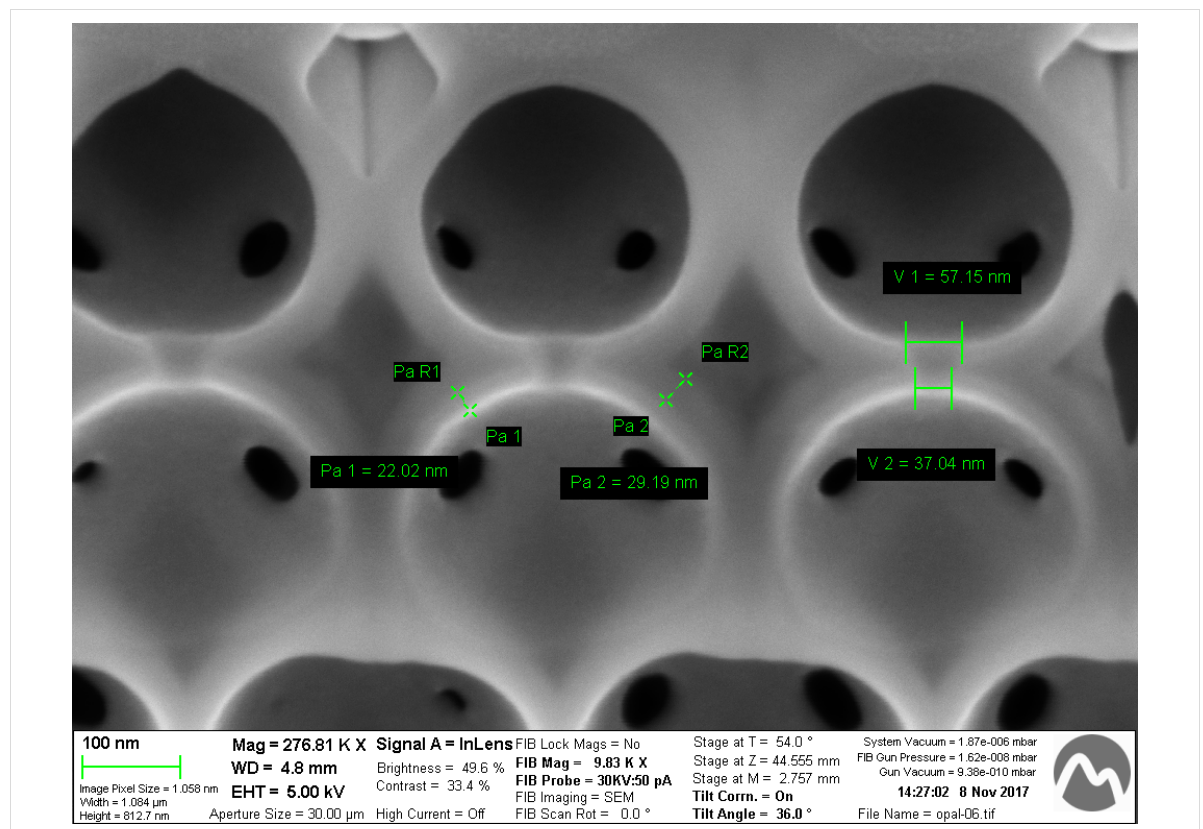
Figure 4: Cross section of Al 2 O 3 /TiO 2 shells after TiO 2 layer deposition. Conformal shells are observed covering the Al 2 O 3 layer. Pa1 stands for the thickness of TiO 2 and Pa2 stands for the thickness of Al 2 O 3